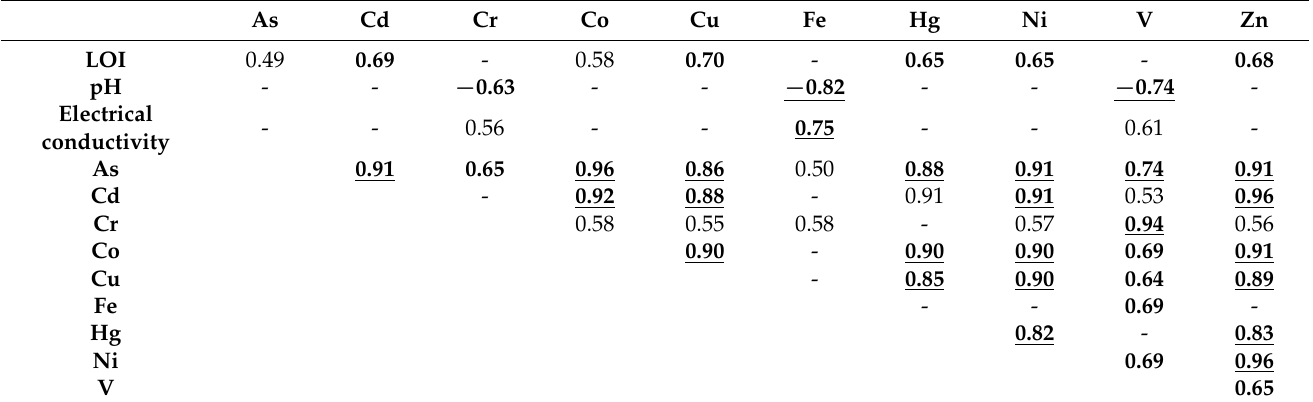
Table 5. Spearman correlations (rho values) in the sediments of the Einsiedel Reservoir ( n =